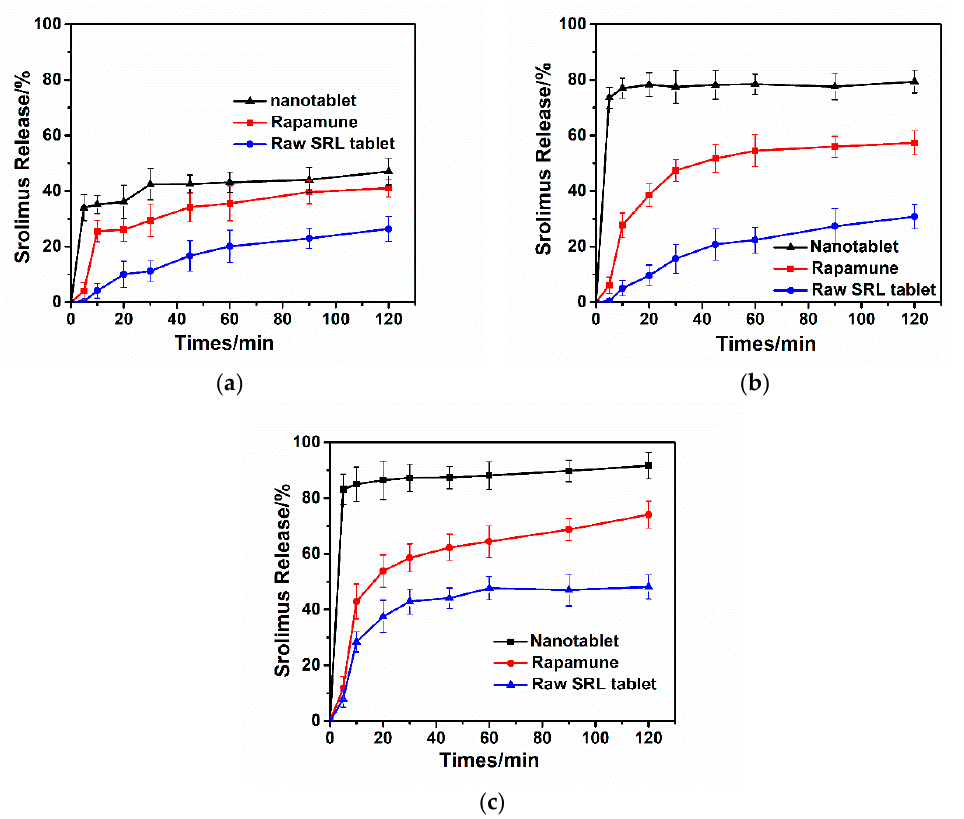
Figure 11. Dissolution profiles of nanotablet, Rapamune ® and raw SRL tablet ( a ) pH = 1.2; ( b ) pH = 4.5; ( c ) pH = 6.8.